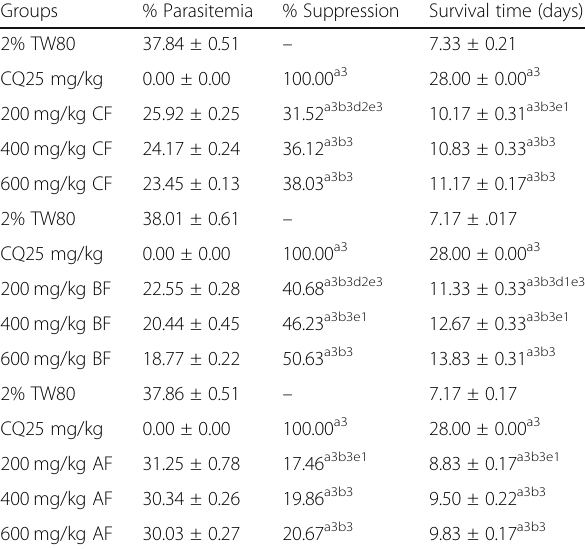
Table 7 Parasitemia and survival time of infected mice treated with solvent fractions of the leaves of Olea europaea in the 4- day suppressive